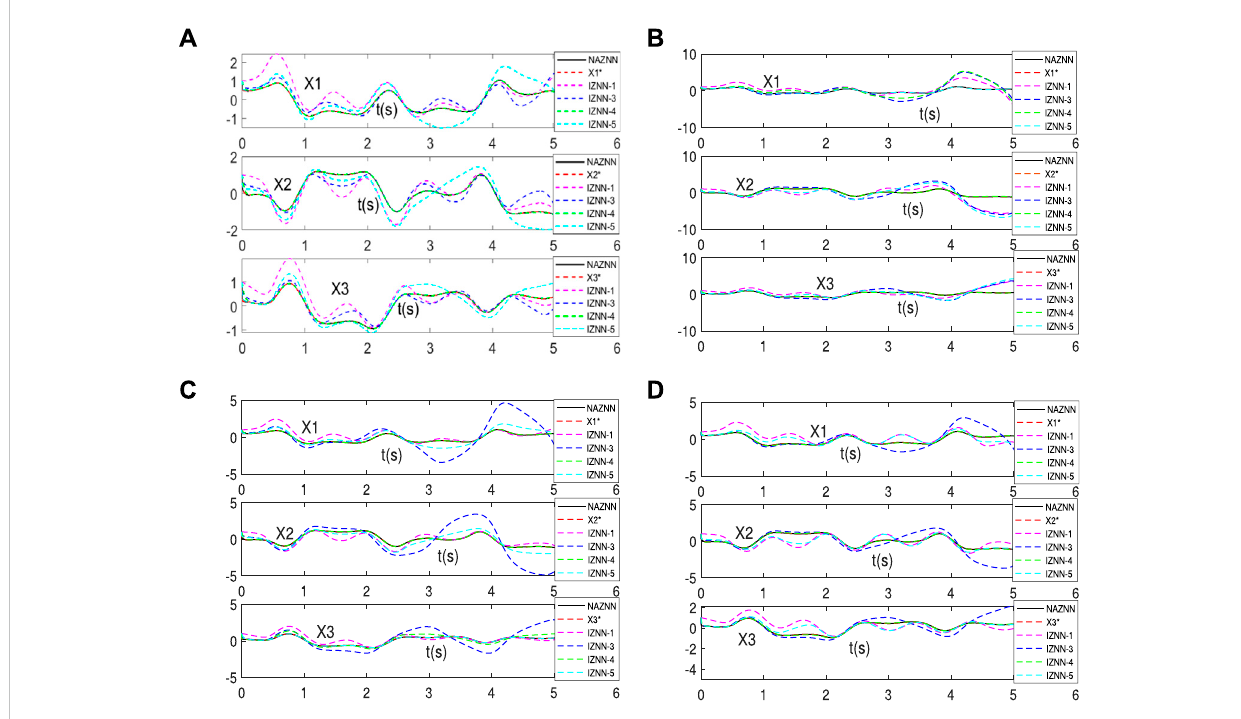
FIGURE 3 Neural state solution of NAZNN model and IZNN model for solving Eq.1 with different noises, (A) is add Y(t)=0.5, (B) is add Y(t)=0.5t, (C) is add Y(t) =cost, (D) is add exponential